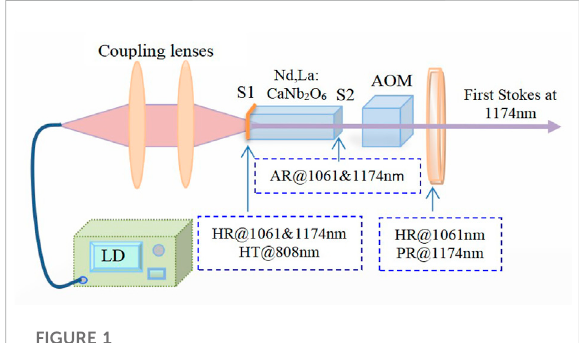
FIGURE 1 Schematic showing the experimental layout of the acousto- optic Q-switched Nd,La:CaNb 2 O 6 self-Raman